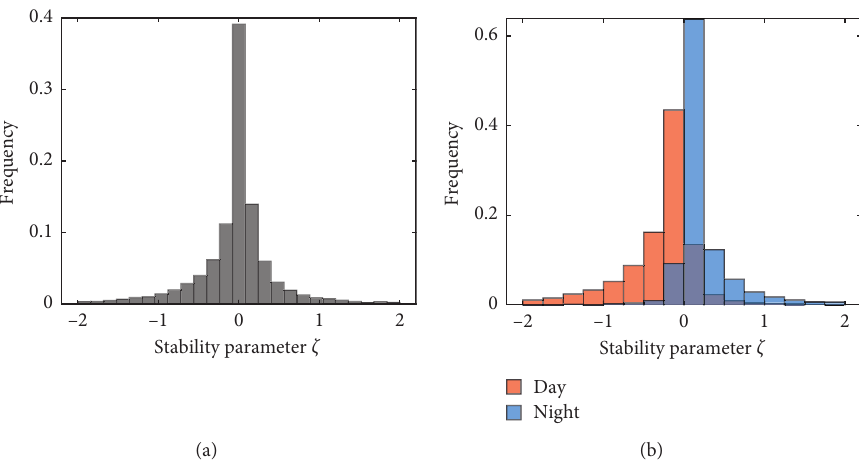
Figure 2: Histograms of the frequency distribution of atmospheric stability throughout the year. All in (a) and day and night in (b). Table 2: Atmospheric stability during different seasons during the day and night. Day Night Spring −